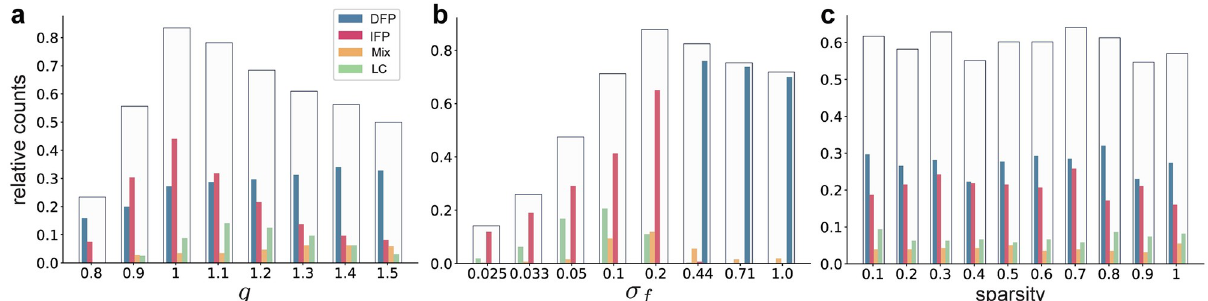
Fig 6. The effect of parameters prior to optimization on the diversity of the emergent solutions. Relative count shows the number of trainable networks divided by the total number of networks for each specified value of parameters. Transparent bars show the relative count of trainable networks and the inner bars show the corresponding emergent types for each specified value of parameters. a , The strength of connections within the initial connectivity matrix J . b , The variance of feedback weights. c , The sparsity of J .